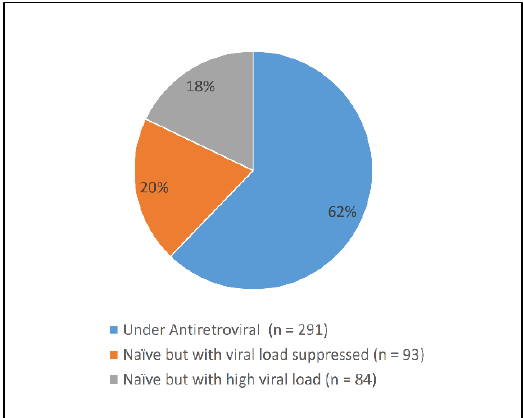
Figure 1. Status of patients at enrollment.